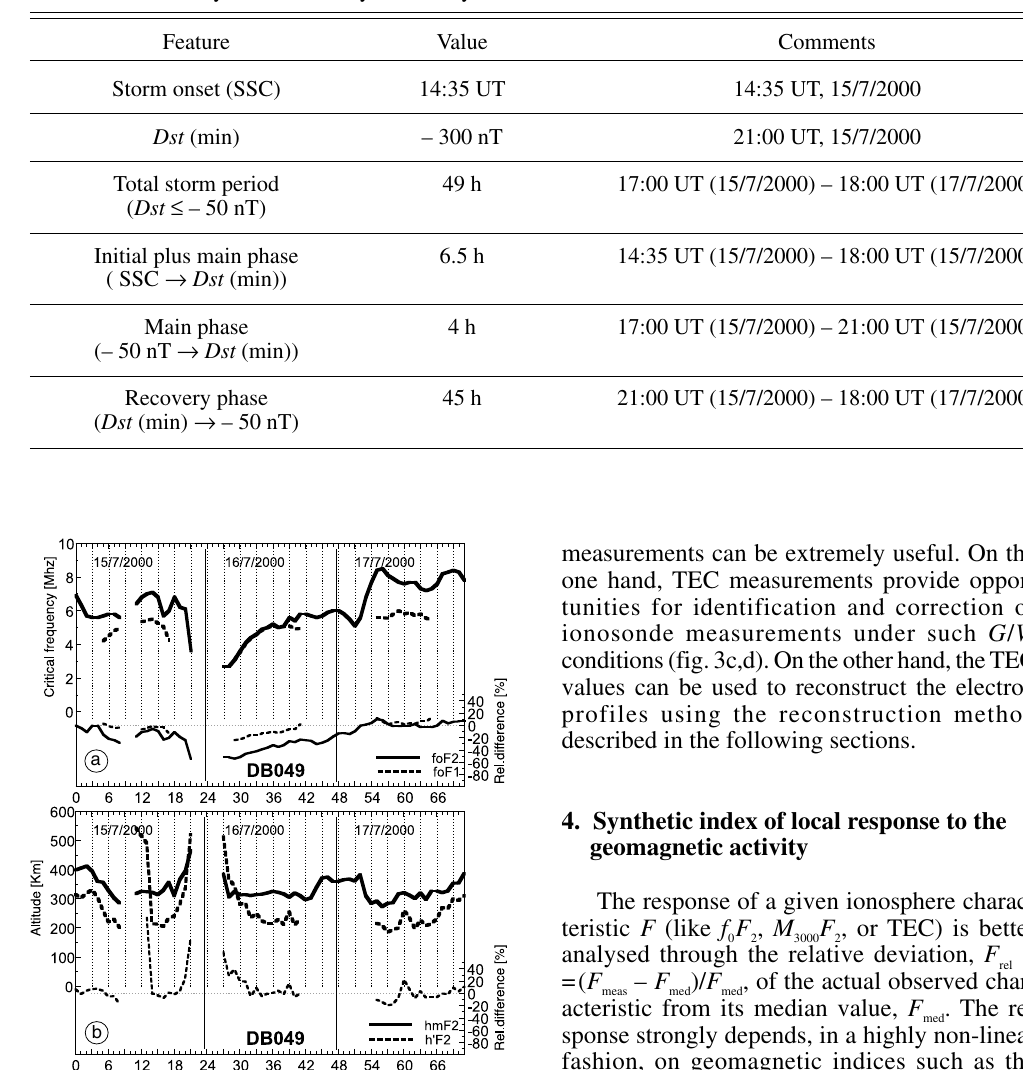
Table III. Summary of the 15th July - 17th July 2000 storm